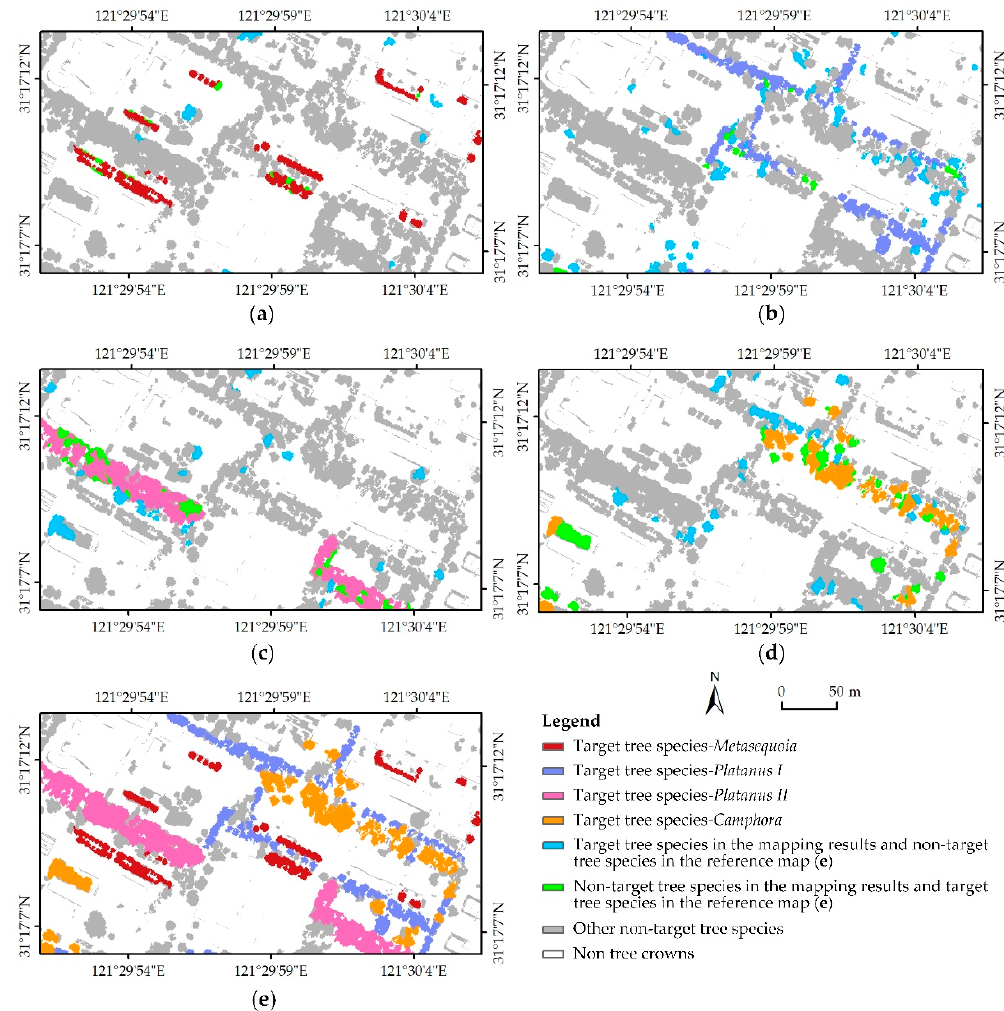
Figure 8. The best mapping results of four tree species using the proposed method. ( a ) Mapping result of Metasequoia using VBSD for χ 2 distance. ( b ) Mapping result of Platanus I using VBSD for χ 2 distance. ( c ) Mapping result of Platanus II using VBSD for χ 2 distance. ( d ) Mapping result of Camphora using VBSD for L 2 distance. ( e ) Reference map of four tree species.